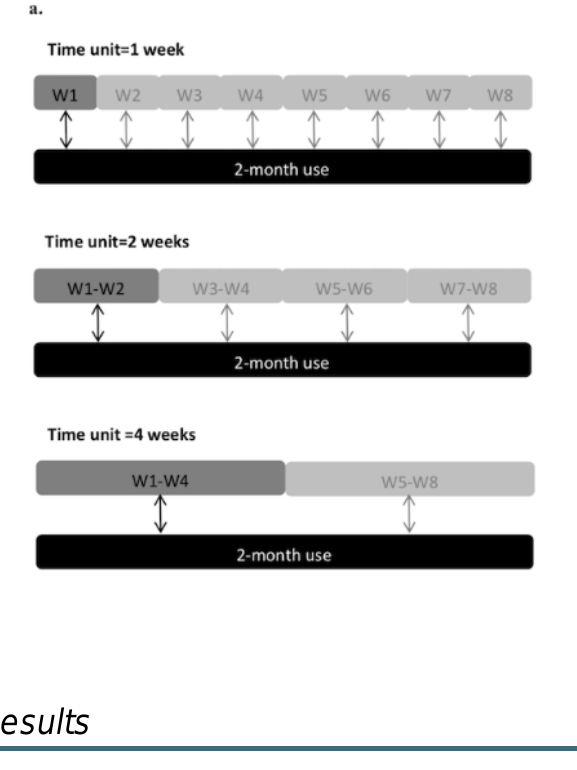
Figure 2. Illustration of validating the temporal stability of app-generated parameters. (a) Fundamental time unit. We chose 1 week, 2 weeks, and 4 weeks as the fundamental time units. The correlations among different time units and the 2-month use were analyzed. (b) Independent cycle. We determined independent cycle of smartphone use by calculating the correlations of 2 independent use periods with different time intervals. W1, W2,...W8: Week 1, Week 2,...Week 8; TI: Time interval